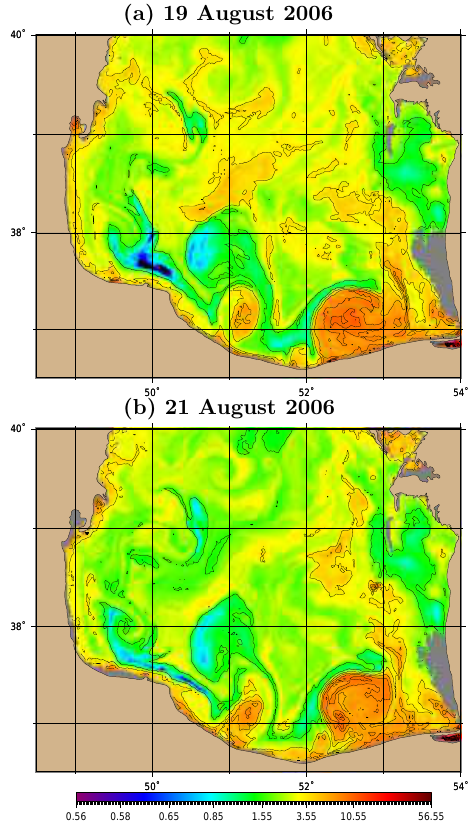
Figure 9. Chlorophyll concentration (in mg m − 3 ) on (a) 19 Au- gust 2006 and (b) 21 August 2006. The chlorophyll concentration contours are plotted with different colours and intervals for a better visualization of the structure.